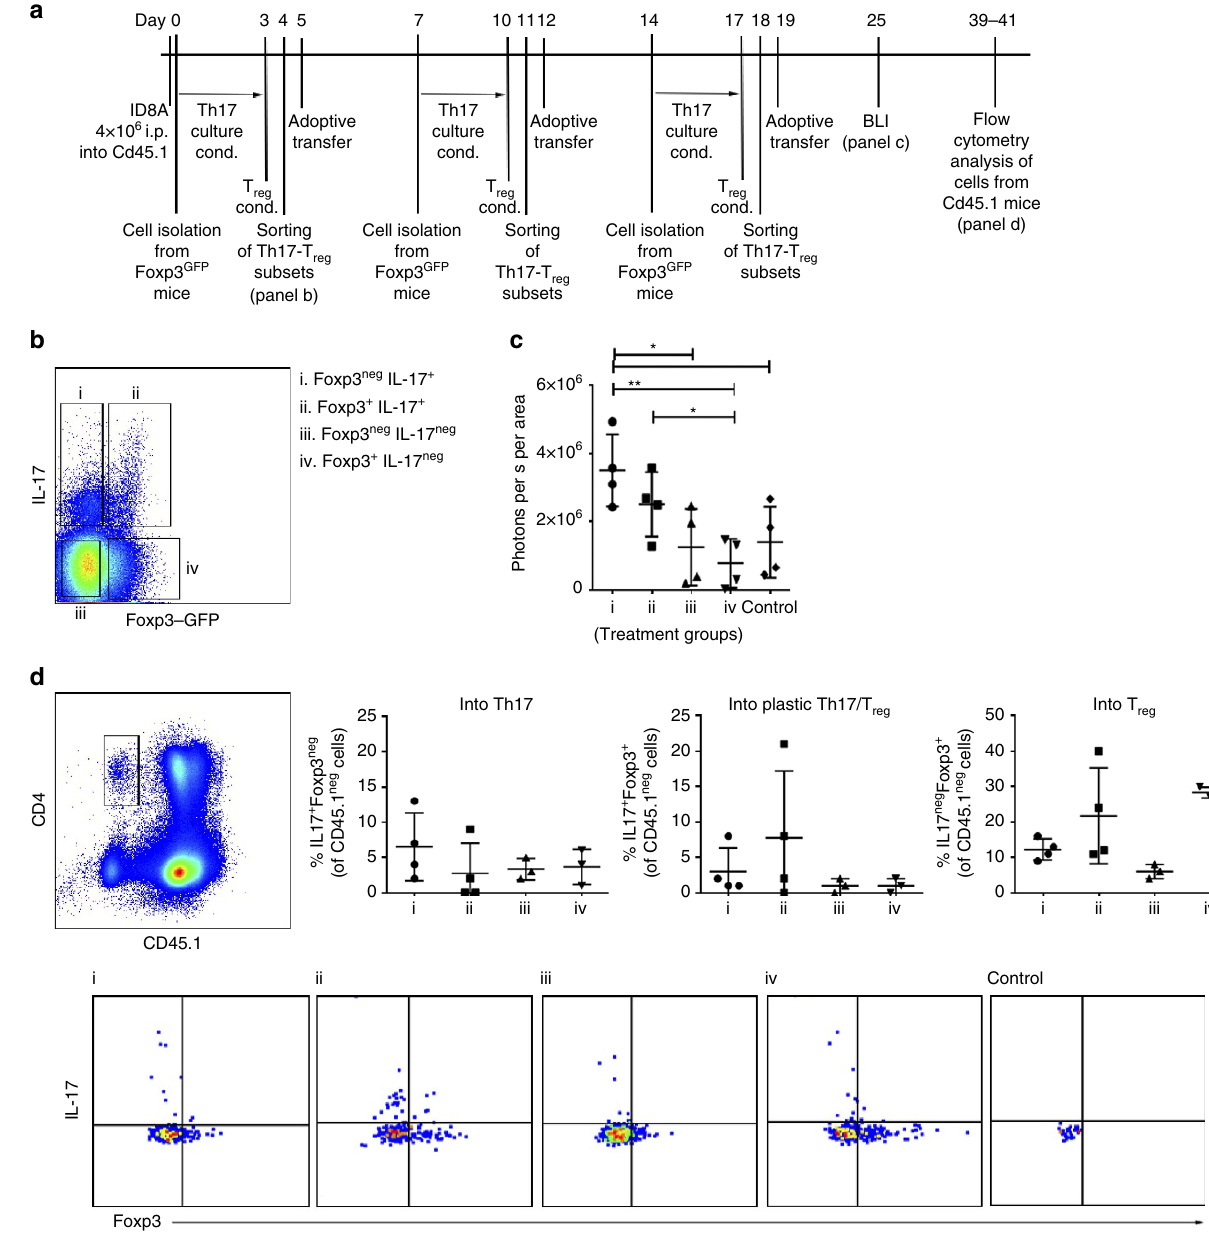
Figure 3 | Transdifferentiation of adoptively transfered Foxp3 neg/ þ IL-17A þ T cells. ( a ) Timeline of the experiment: CD4 þ T cells from Foxp3 GFP reporter mice were cultured under Th17 (IL-6, IL-23, TGF- b , 3 days)/T reg (TGF- b , þ 1 day)-driving conditions. Foxp3 neg IL-17A þ (i), Foxp3 þ IL-17A þ (ii), Foxp3 neg IL-17A neg (iii) and Foxp3 þ IL-17A neg (iv) CD4 þ T cells were sorted and injected i.p. into ID8A-tumour bearing mice on days 5, 12 and 19. ( b ) Following staining with IL-17A-detection kit, live/CD4 þ /Th17–T reg subsets (i–iv) were flow sorted using the presented gating strategy (note that the 3h activation with PMA and ionomycin before cell sorting results in a reduced mean fluorescence intensity of Foxp3-GFP; see Supplementary Fig. 9). The fluorescence-activated cell sorting (FACS) gating strategy for live CD4 þ cells is presented in Supplementary Fig. 8c. ( c ) Th17–T reg subsets (i–iv) were injected i.p. into ID8A-luc tumour-bearing Cd45.1 mice on days 5, 12 and 19 and tumour growth monitored by bioluminescence (day 25, n ¼ 4 mice per group) compared with control tumour-bearing mice. ( d ) CD4 þ CD45.1 neg cells from ID8A-luc tumour-bearing Cd45.1 mice, receving adoptively transfered Th17–T reg subsets (groups i–iv, n ¼ 4 mice per group), were analysed on day 40 ± 1 for IL17A production and Foxp3 expression. Statistical analysis of the percentages of Foxp3 neg IL-17A þ , Foxp3 þ IL-17A þ and Foxp3 þ IL-17A neg of CD4 þ CD45.1 neg cells in each group of mice (top) and representative staining (bottom). The FACS gating strategy of live cells is presented in Supplementary Fig. 8d. All data ( c , d ) are mean ± s.d. * P o 0.05 and ** P o 0.01 by two-tailed Student’s